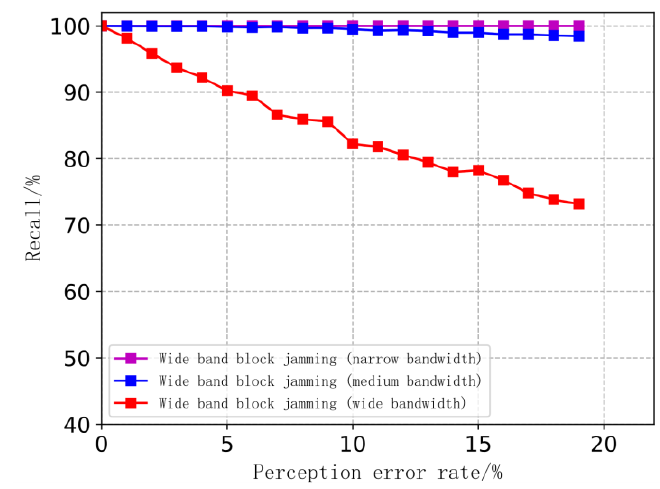
Figure 5. Recall of frequency domain feature extraction of broadband blocking jamming.